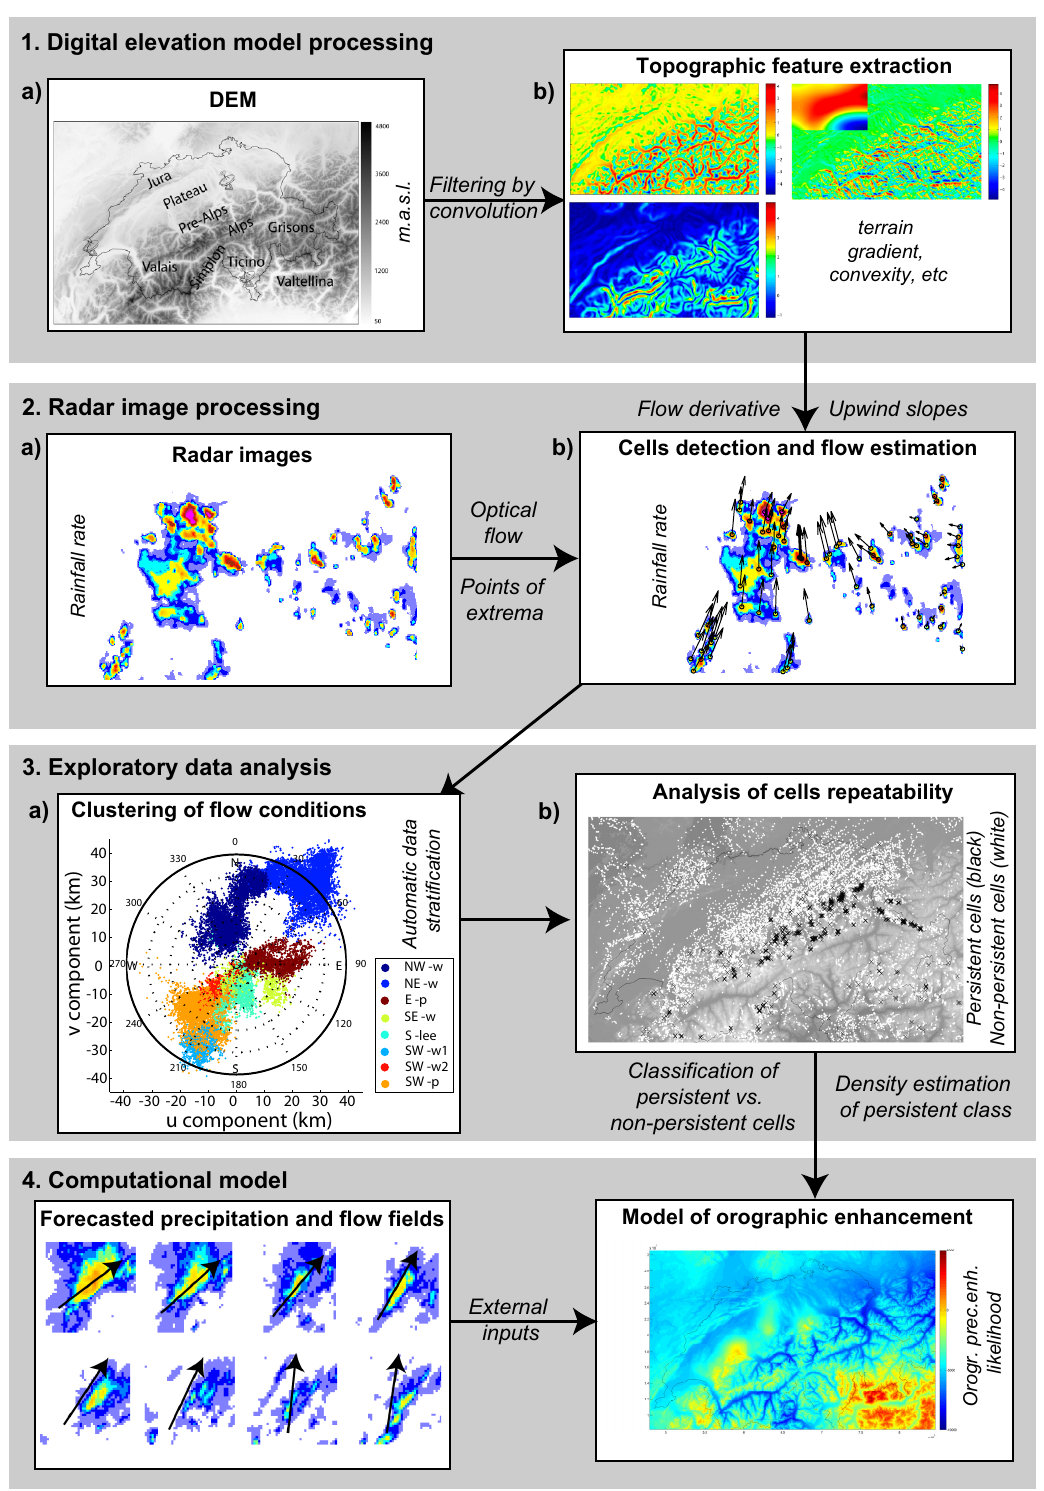
Figure 1. General scheme for data-driven modelling of orographic precipitation enhancement. External nowcasted precipitation and flow fields can be used as inputs for models of orographic precipitation enhancement, i.e. describing the likelihood of precipitation repeatability and persistence due to